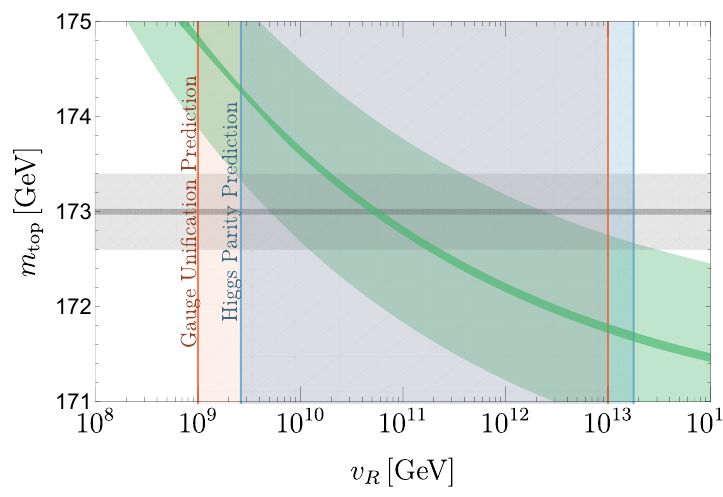
Figure 3 . The predicted top quark mass in Higgs Parity theories is shown in green , as a function of the right-handed symmetry breaking scale. The experimentally preferred top mass is shown as a gray band, leading to the preferred range of v R shown by the vertical blue band. The red band shows the range of v R preferred by gauge coupling